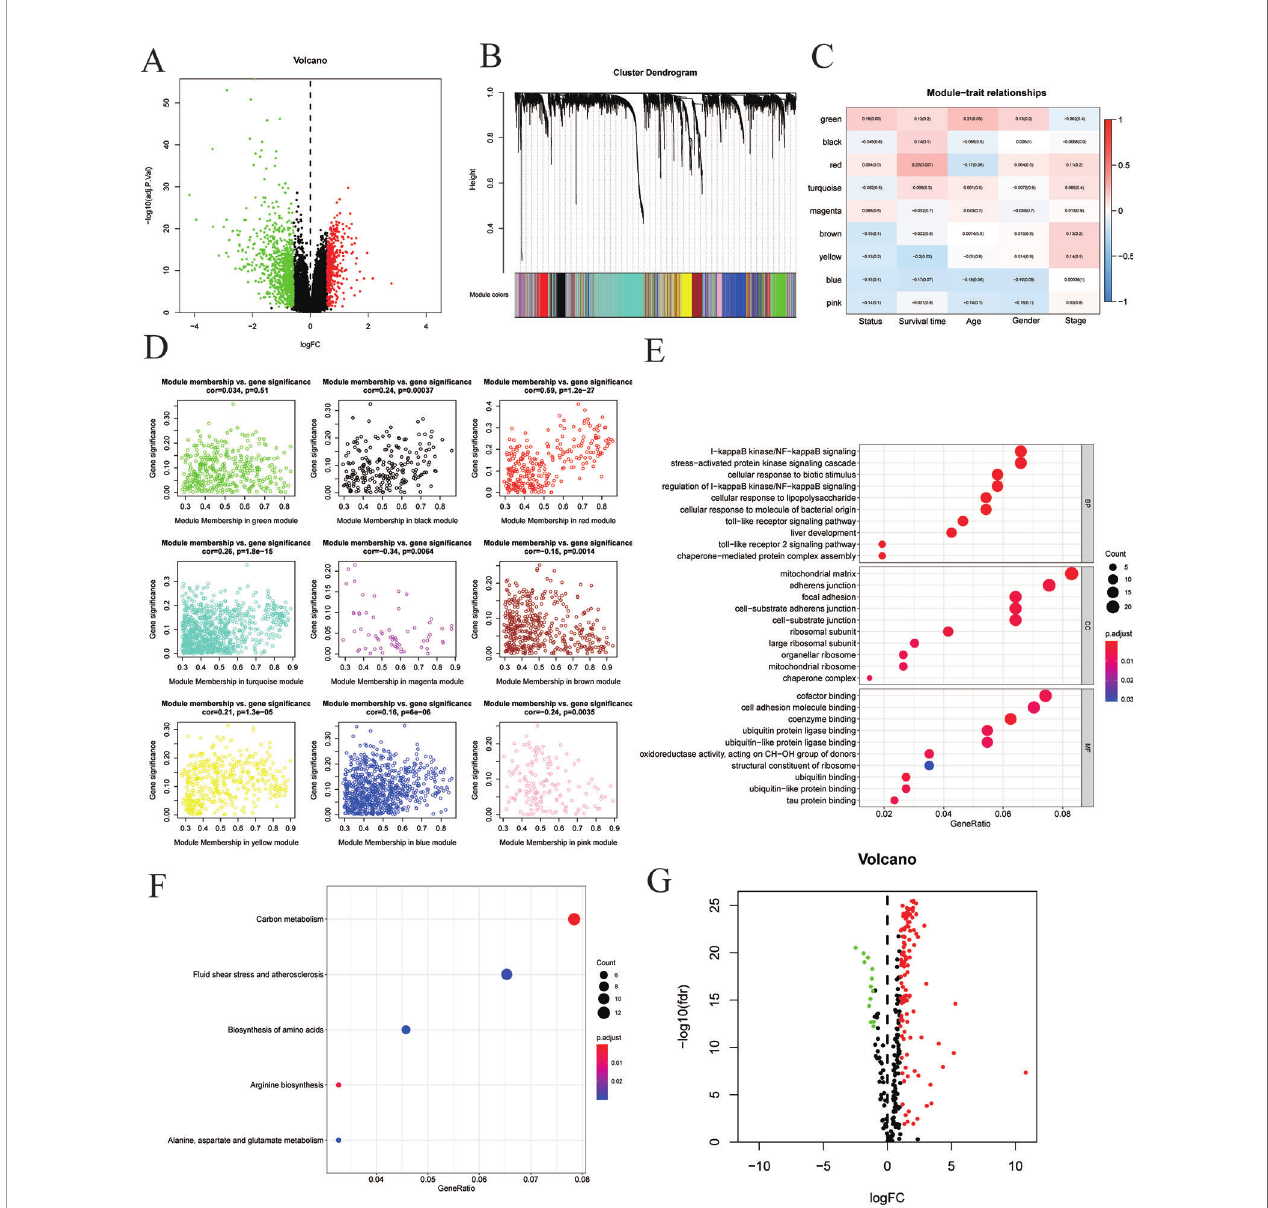
FIGURE 2 | ldenti fi cation of prognostic genes in hepatocellular carcinoma patients. (A) Volcano plot showing differentially expressed genes (DEGs) in hepatocellular carcinoma samples. (B) Clustering dendrogram of genome-wide genes in hepatocellular carcinoma samples. (C) Correlation between modules and traits. Absolute values of correlation coef fi cients between hepatocellular carcinoma status and modules greater than 0.15 were considered as hepatocellular carcinoma-related modules. (D) Module membership in nine hepatocellular carcinoma-related modules. The red module was the most signi fi cant module. (E , F) GO and KEGG analysis revealed the most signi fi cant biological process (BP), molecular function (MF), cellular component (CC), and pathways correlated with the high-risk group genes in the red module. (G) Volcano plot revealed DEGs in the red